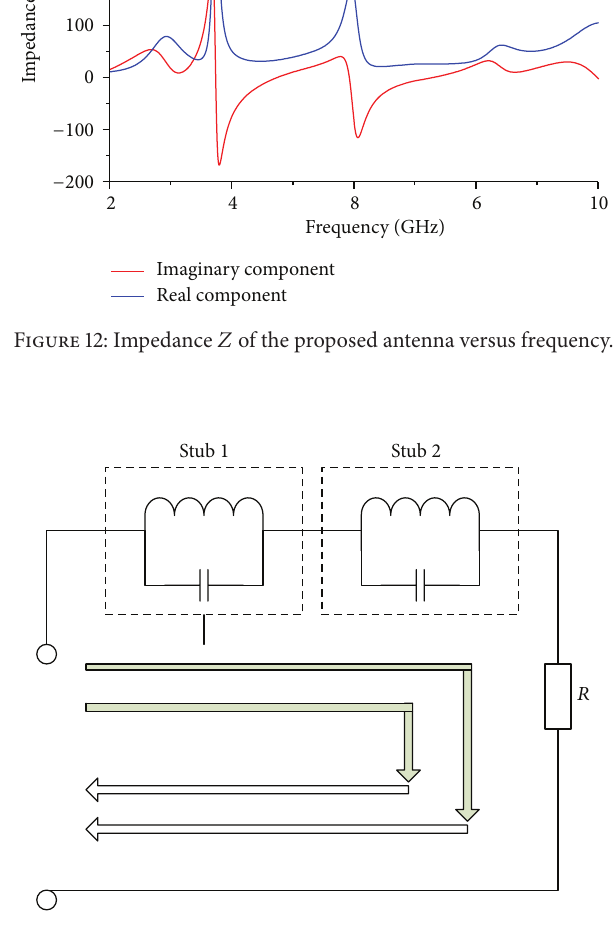
Figure 13: Approximate equivalent circuit of the proposed antenna.